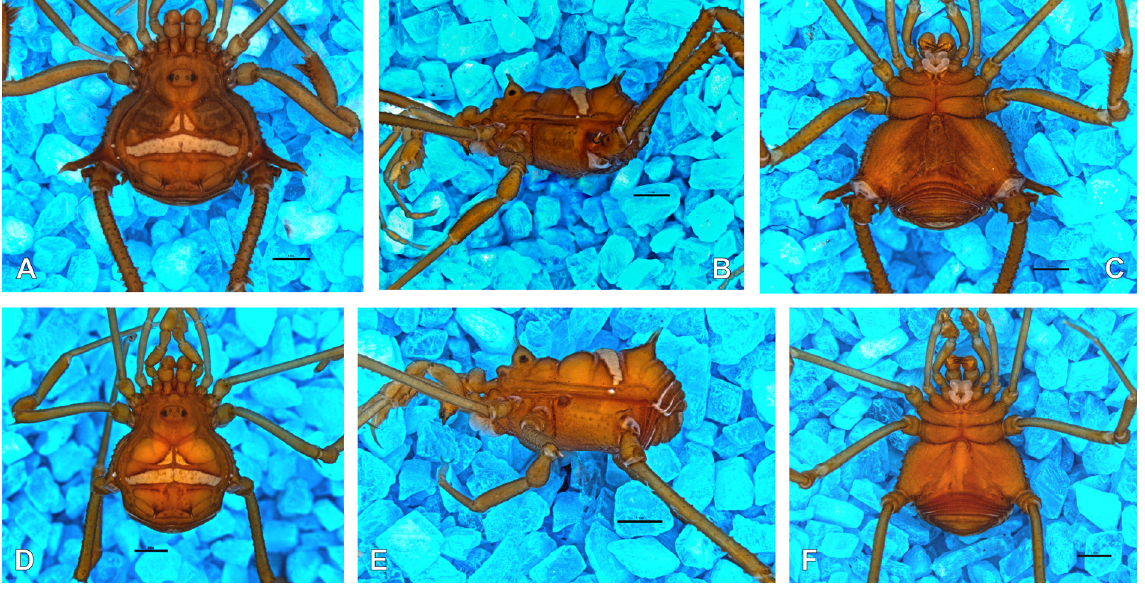
Fig. 15. Lacronia ricardoi Kury, 2003 (MZSP 21373), specimens in alcohol. A–C . Holotype, ♂ (MZSP 21373). A . Habitus, dorsal view. B . Same, lateral view. C . Same, ventral view. D–F . Paratype, ♀ (MZSP 10589). D . Habitus, dorsal view. E . Same, lateral view. F . Same, ventral view. Scale bars = 1